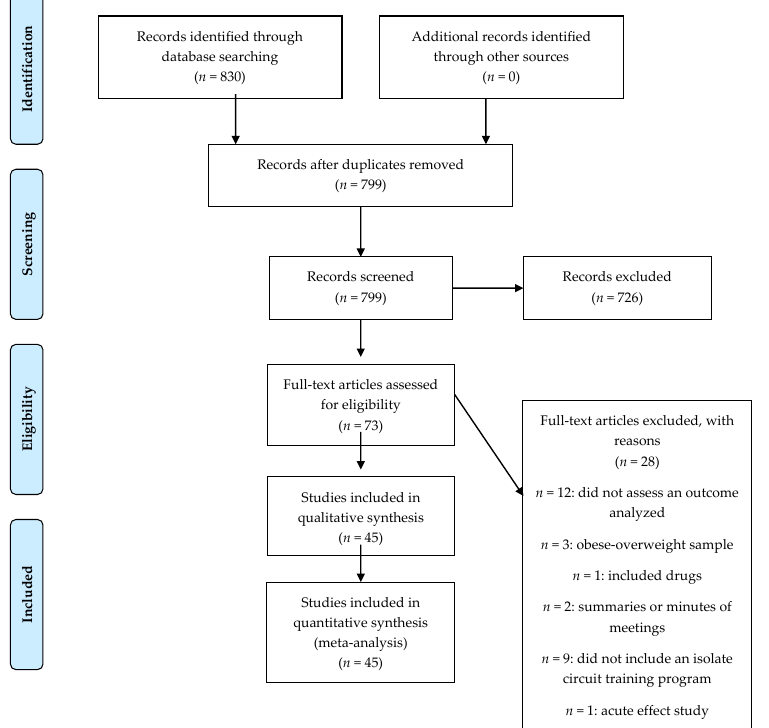
Figure 1. Flow diagram of the included studies.